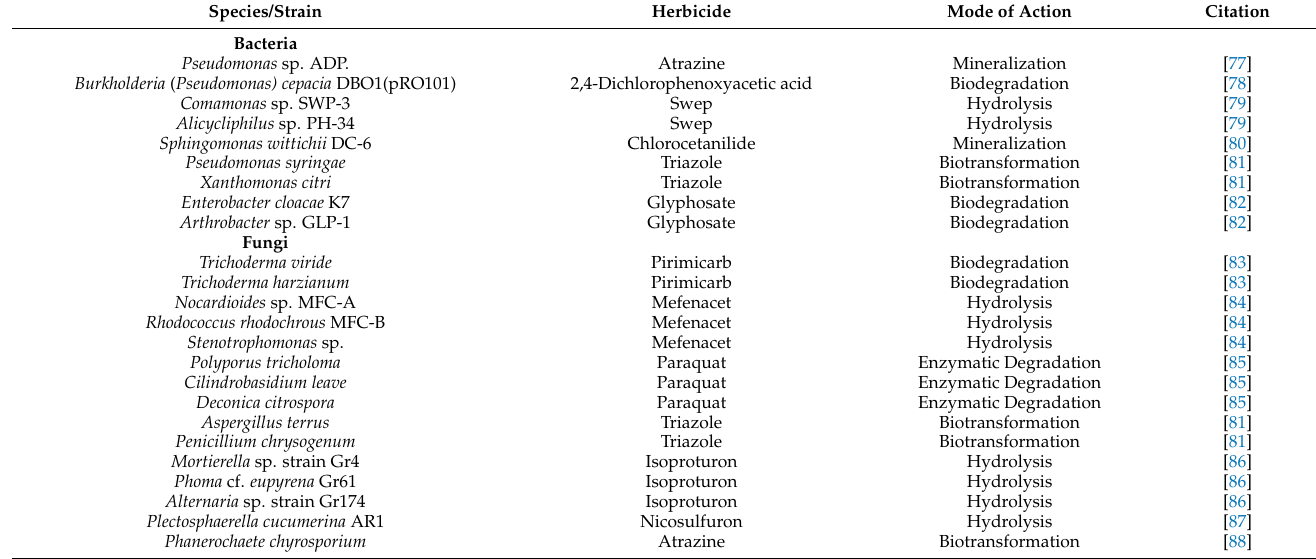
Table 1. List of bacterial (top) and fungal (bottom) taxa that have demonstrated herbicidal biodegradation or mineralization capabilities. Presented are species/strain names, herbicides and mode of actions of degradation.